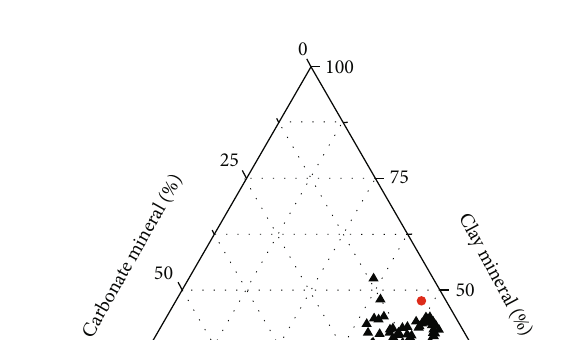
Figure 4: Bar chart of mineral proportions.